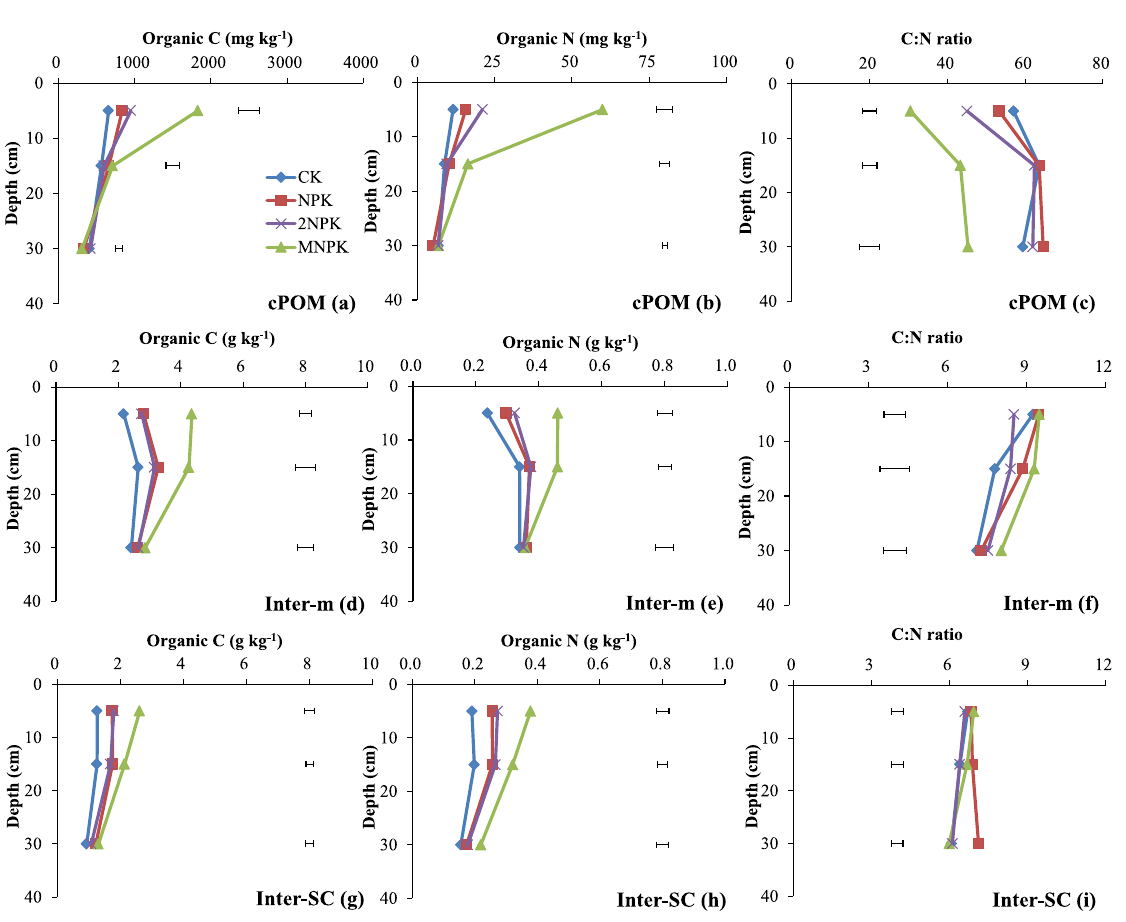
Figure 3. Organic C and N concentrations and C/N ratios of the macroaggregate fractions to 40 cm deep in the control treatment (CK), chemical fertilizer treatments (NPK and 2NPK), and combined manure and chemical fertilizer treatment (MNPK). Each value is the mean of three replicates. The horizontal lines indicate the least significant difference values at the 0.05 level (LSD0.05) for the different treatments at the different depths. The abbreviations for aggregates of each size are shown in the footnote to Table